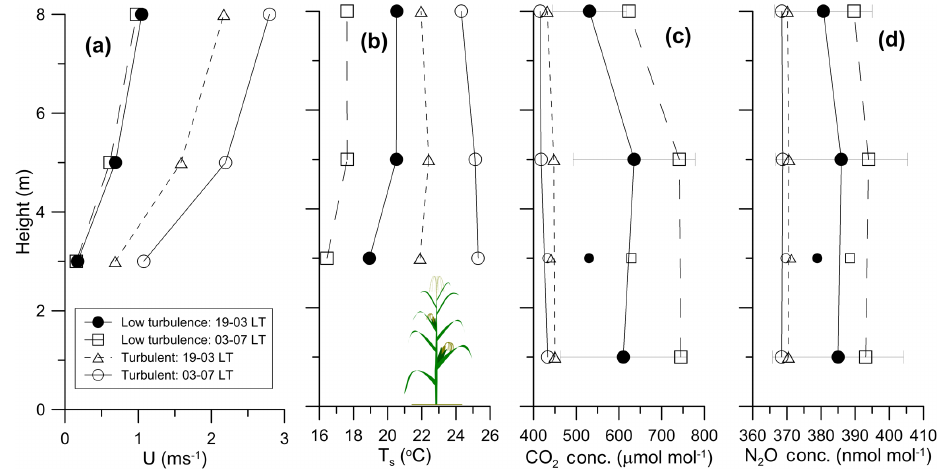
Figure 5. Mean profiles of wind speed, sonic temperature, and concentrations of CO 2 and N 2 O under different friction velocity and time domain classes for the entire study period. The mean wind speed ( U , panel a ), sonic temperature ( T s ; panel b ), and concentration profiles of CO 2 (c) and N 2 O (d) when the air at 8m had low turbulence ( u ∗ ≤ 0.05ms − 1 ) or turbulent ( u ∗ > 0.05ms − 1 ) between 19:00 and 03:00LT and 03:00 and 07:00LT are indicated. Canopy height was 2.8m. Smaller symbols not connected with lines represent concentration measurements excluded from mass accumulations due to their close proximity to the canopy